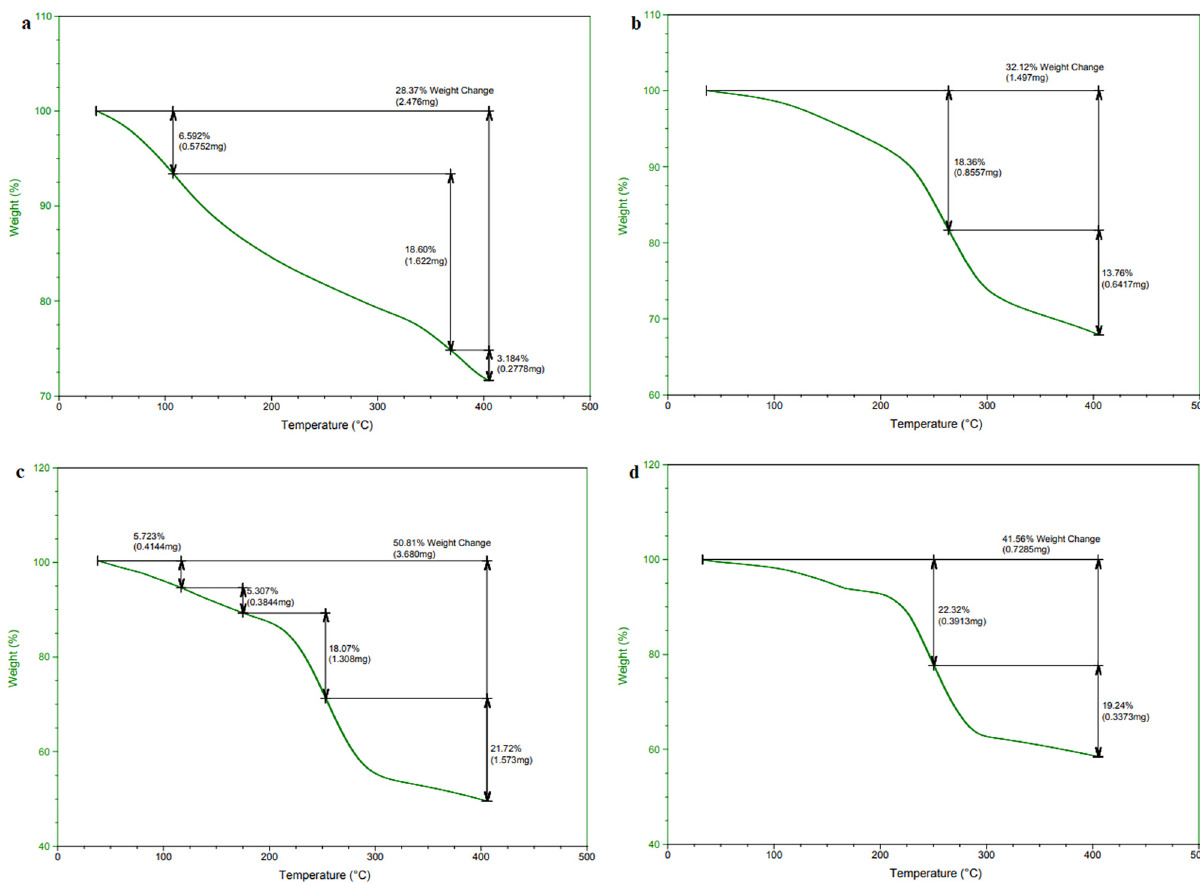
Figure 13: TGA spectra of ( a ) KPA, ( b ) Mg - PA, ( c ) PVA, and ( d ) Mg - PVA with their indicated weight losses.